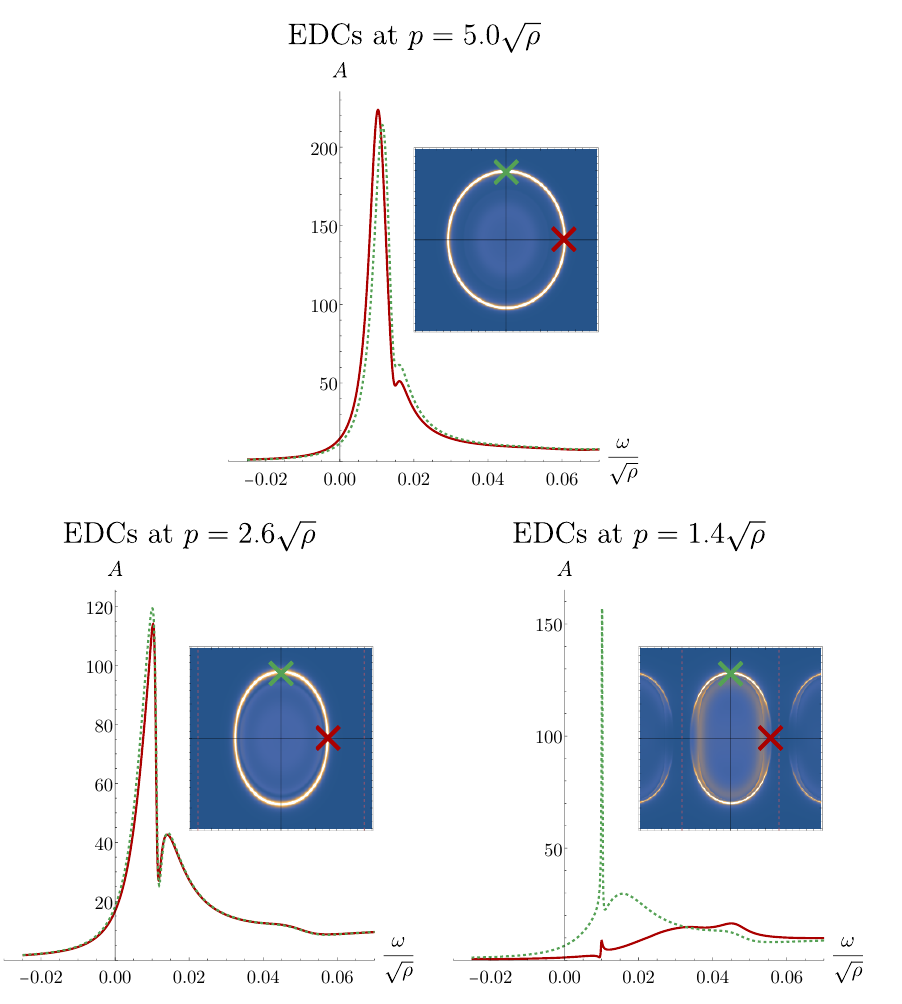
Figure 10 . Energy distribution curves in for strong unidirectional holographic lattices ( (cid:21) = 8 : 0 ) in direct quantization near and far from the Umklapp surfaces. When the BZ boundaries are far away, as in the top picture, the EDCs look very similar: they both show a well-de(cid:12)ned, sharp peak. The dip on the right shoulder of the peak corresponds to the alternate quantization zero. When the BZ boundary is brought closer, (cid:12)rst some asymmetry in the sharpness of the peaks appears. When the BZ boundaries are brought very close, the peak for the EDC near the BZ boundary gets destroyed by the zero